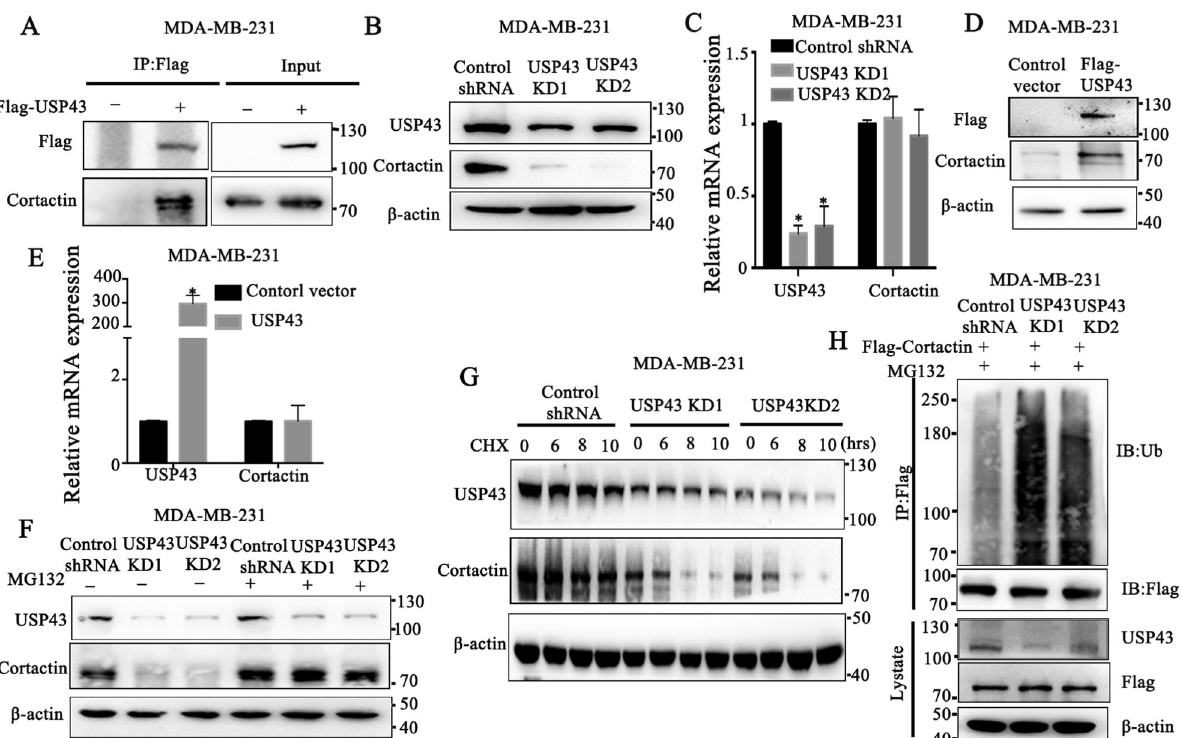
Fig. 5 USP43 interacts with and deubiquitinates cortactin. A Cortactin were determined by immunoblotting in MDA-MB-231 cells expressing Flag-tagged USP43 or control vector following Flag-tag immunoprecipitation. B Cortactin were determined by immunoblotting in MDA-MB-231 cells expressing USP43 shRNA or control shRNA. C Cortactin and USP43 transcripts were determined by qRT-PCR in MDA-MB- 231 cells expressing USP43 shRNA or control shRNA. P value was determined using Student ’ s t-test (* p < 0.001). Error bars represent mean ± s.d. D Cortactin were determined by immunoblotting in MDA-MB-231 cells expressing fl ag-tagged USP43 cDNA or a control vector. E Cortactin and USP43 transcripts were determined by qRT-PCR in MDA-MB-231 cells expressing USP43 cDNA or a control vector. F Cortactin and USP43 were determined by immunoblotting in MDA-MB-231 cells stably expressing USP43 shRNA or control shRNA and treated with proteosome inhibitor MG132 or a control vehicle. G Cortactin and USP43 were determined by immunoblotting in MDA-MB-231 cells stably expressing USP43 shRNA or control shRNA and treated with protein synthesis inhibitor cycloheximide (CHX) or a control vehicle. H MDA-MB- 231 cells stably expressing Flag-tagged cortactin and USP43 shRNA or control shRNA were treated with proteosome inhibitor MG132. Ubiquitination of cortactin determined by immunoblotting of ubiquitin following Flag-tag